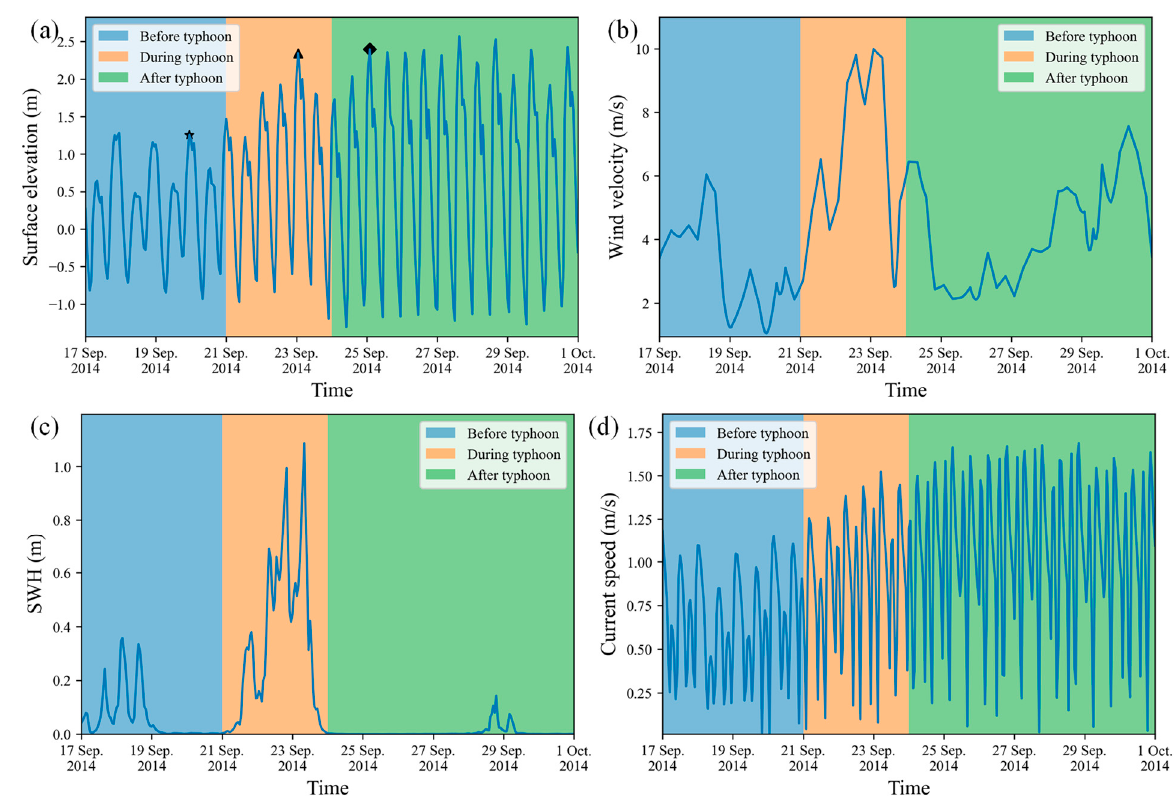
Figure 6. Time history of ( a ) surface elevation, ( b ) wind velocity, ( c ) significant wave height (SWH) and ( d ) current speed. The blue, orange and green shadow color means before, during and after typhoon. The star, upper triangular, and diamond markers in ( a ) correspond to the simulation start times shown in Table 3.